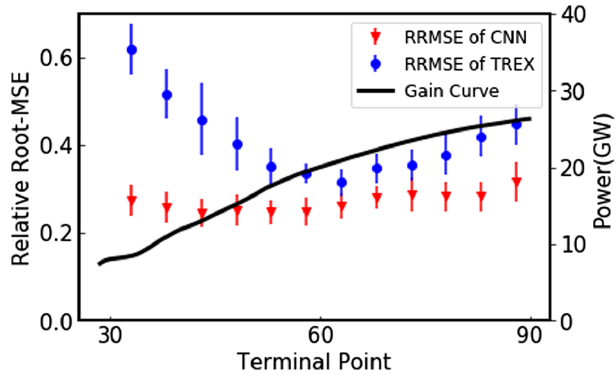
FIG. 3. The SetLong RRMSE for both the CNN (red) and TREX (blue) as a function of undulator length. The gain curve shows the average FEL power vs undulator